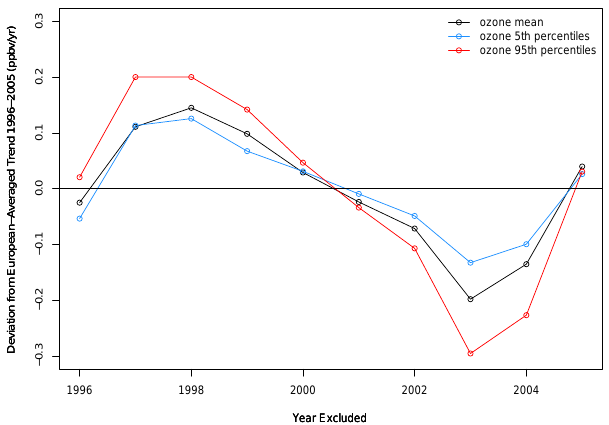
Fig. 6. The deviation from the 1996–2005 inclusive European- averaged annual trend in mean, 5th and 95th percentiles when indi- vidual years are excluded from analysis